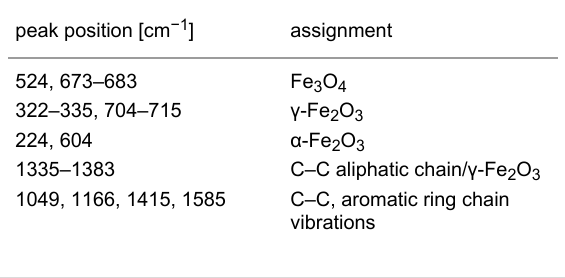
Table 3: Positions of the most intensive lines in the Raman spectra of tested samples